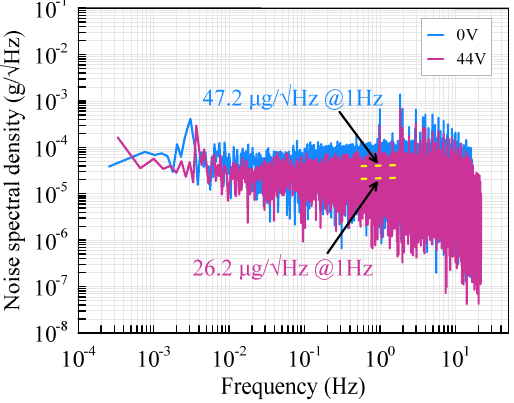
Figure 12. Frequency response of the accelerometer.